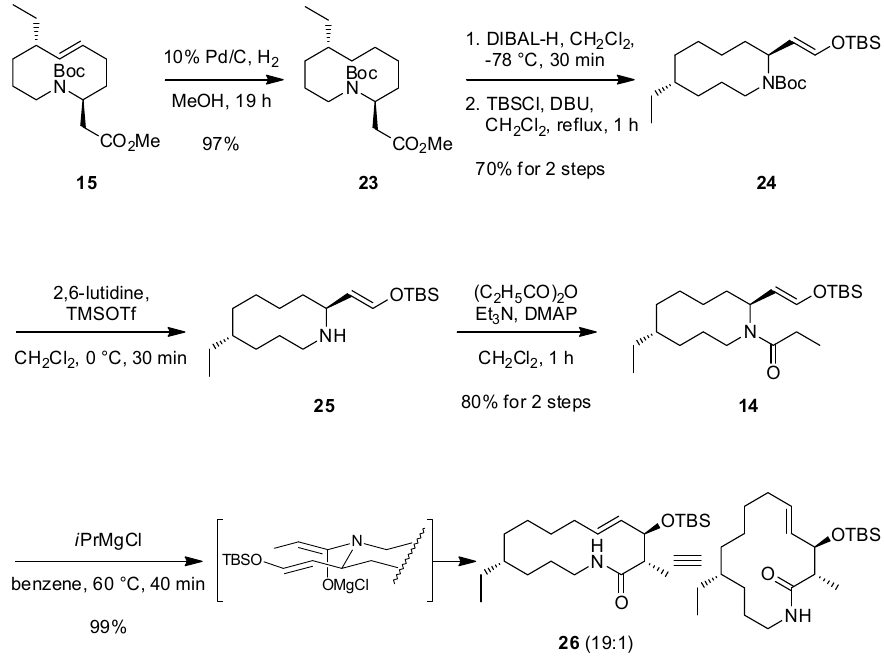
Scheme 3. Synthesis of macrolactam 26 .